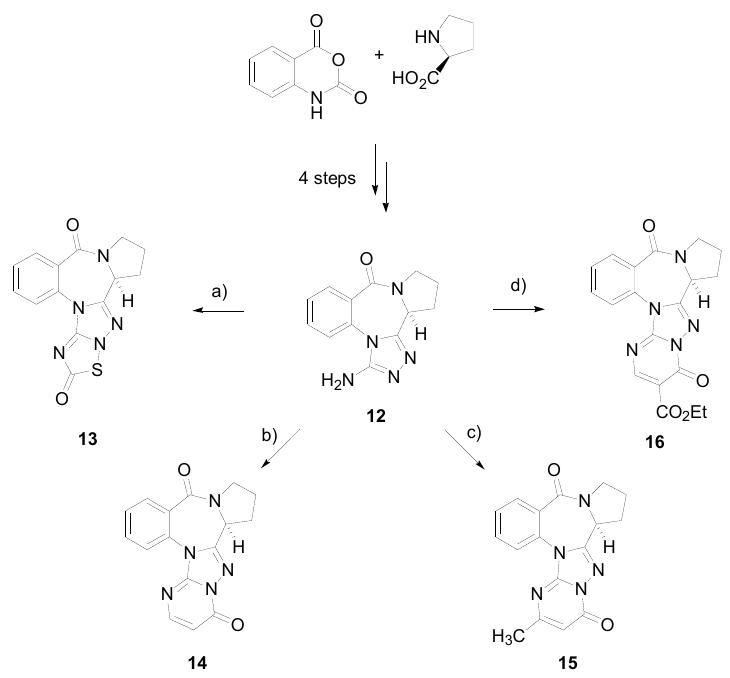
Table 1. The effects of pentacyclic benzodiazepine derivatives (PBDTs) (1 mg/kg, ip)